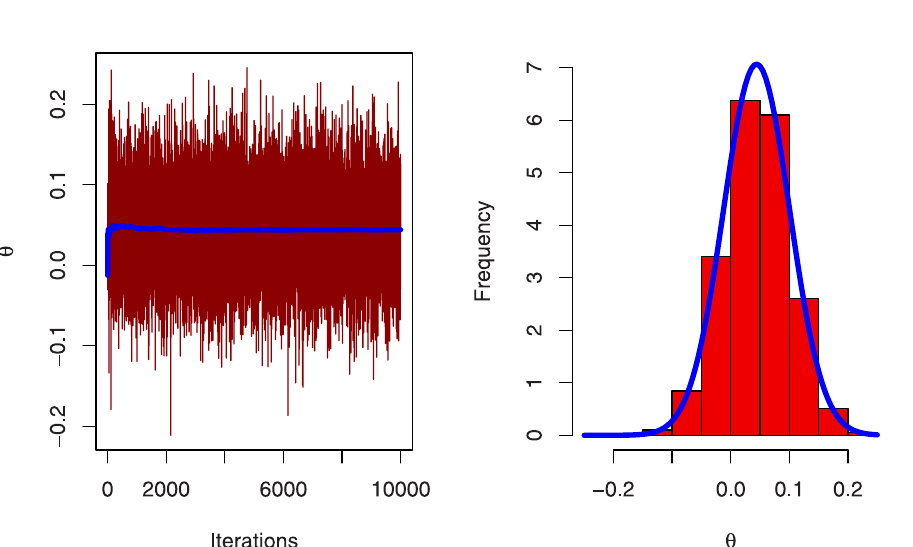
Fig 12. Trace with convergence line and histogram plot with density posterior curve of MCMC result for copula parameter.